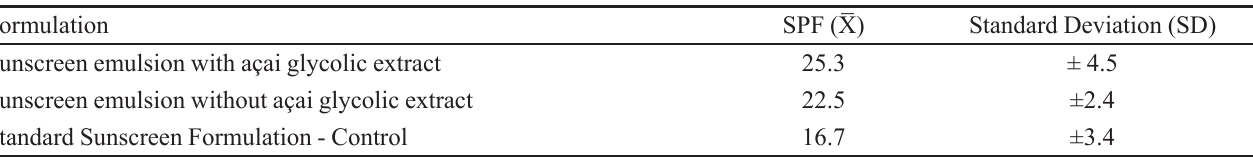
TABLE IV – The in vivo sun protection factor (SPF) values of the O/W sunscreen emulsion containing 1.0% of sodium polyacrylate (R2) Formulation Sunscreen emulsion with açai glycolic extract Sunscreen emulsion without açai glycolic extract Standard Sunscreen Formulation - Control